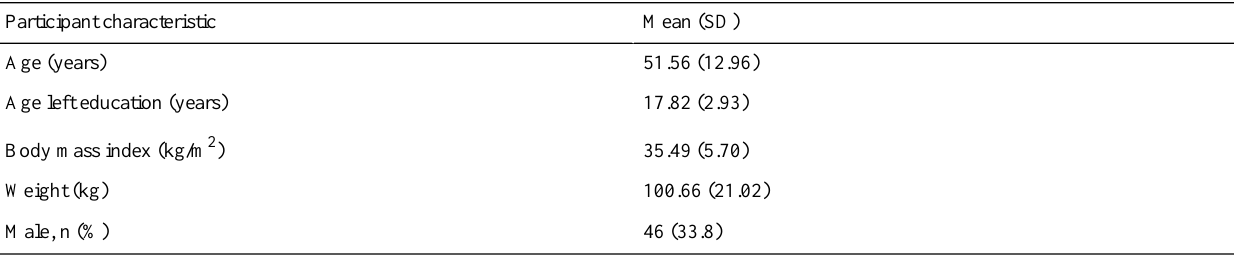
Table 2. Baseline characteristics of